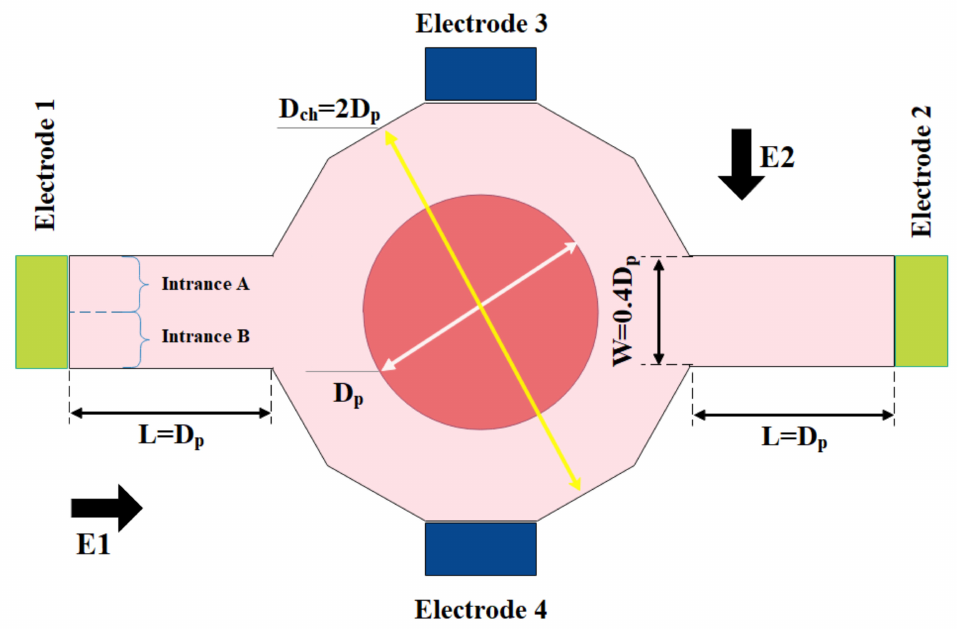
Figure 32. Diagram of the proposed micromixer, showing two microchannels and one suspended particle inside the microchamber